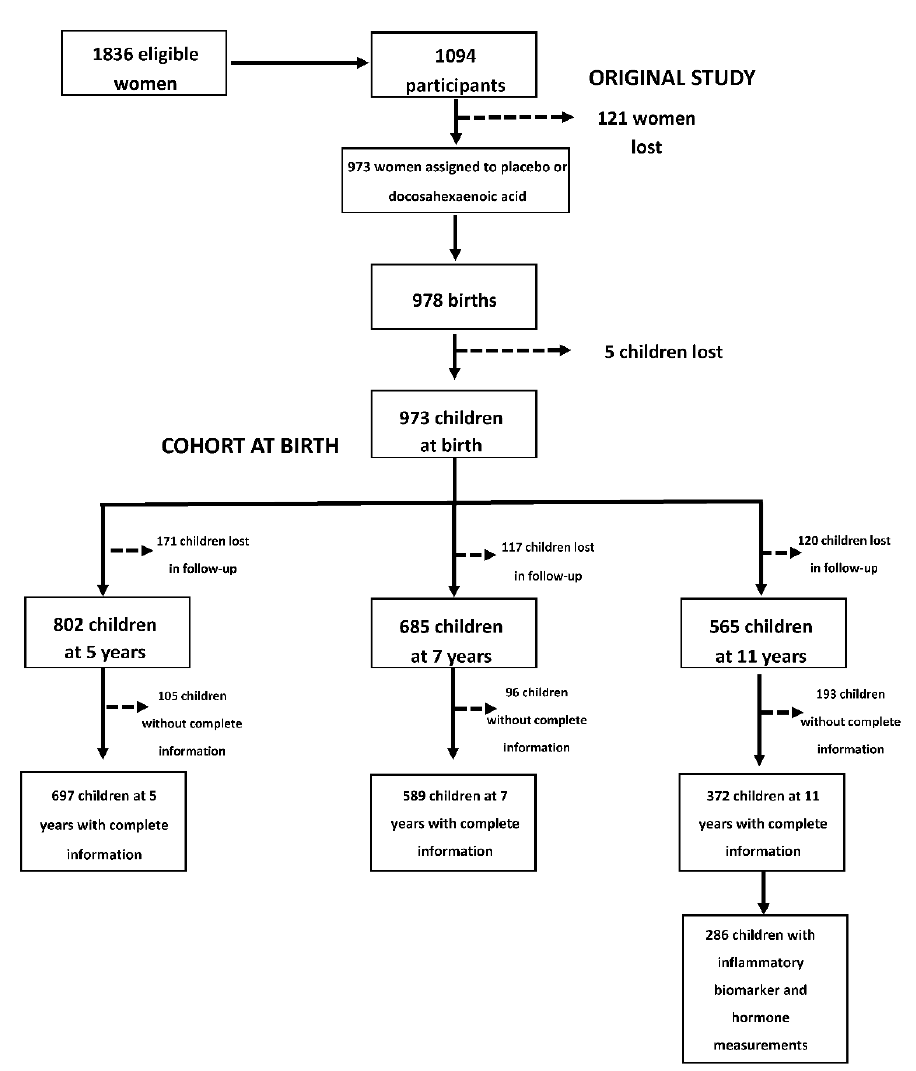
Figure 1. Prenatal Omega-3 fatty acid supplementation and child growth and development (POSGRAD) birth cohort study sample